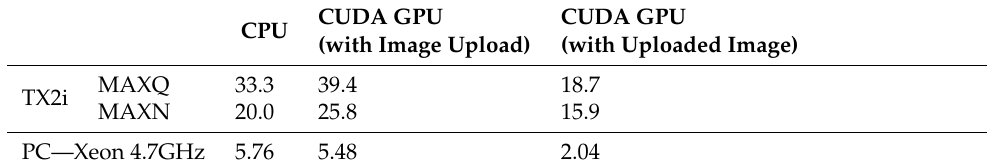
Table 2. Pre-processing times, in ms, with a bilateral filter and shadow